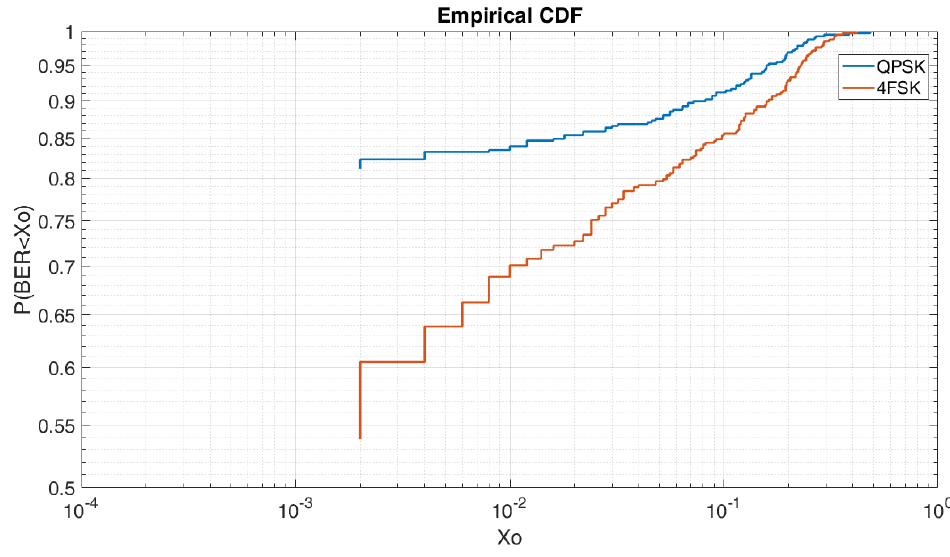
Figure 15. NVIS with groundwave CDF of QPSK and 4FSK.